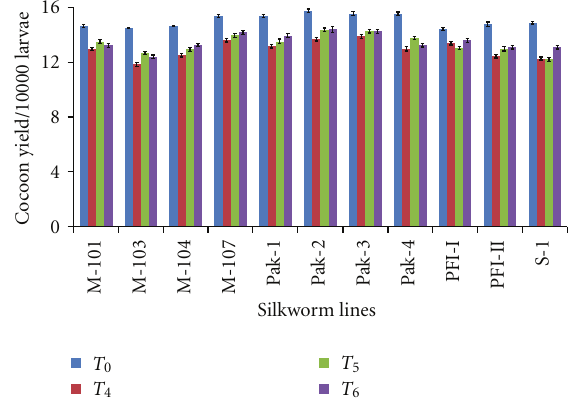
Figure 11: Comparative performance of cocoon yield (mean ± SE) of eleven silkworm lines at 30 ± 1 ◦ C in combination with 55, 65, and 75% RH and controlled conditions of temperature and RH (25 ± 1 ◦ C and 70–80% RH, resp.).